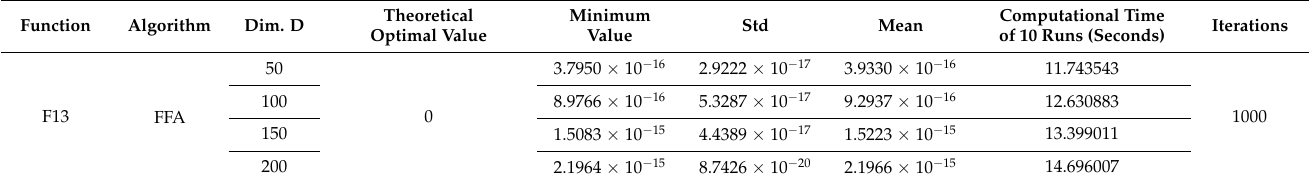
Figure 5. Convergence curves of FFA for the functions: ( a ) F13; ( b ) F14 and ( c ) F15 on 50D, 100D, 150D and 200D. Table 4. Stability of FFA in higher